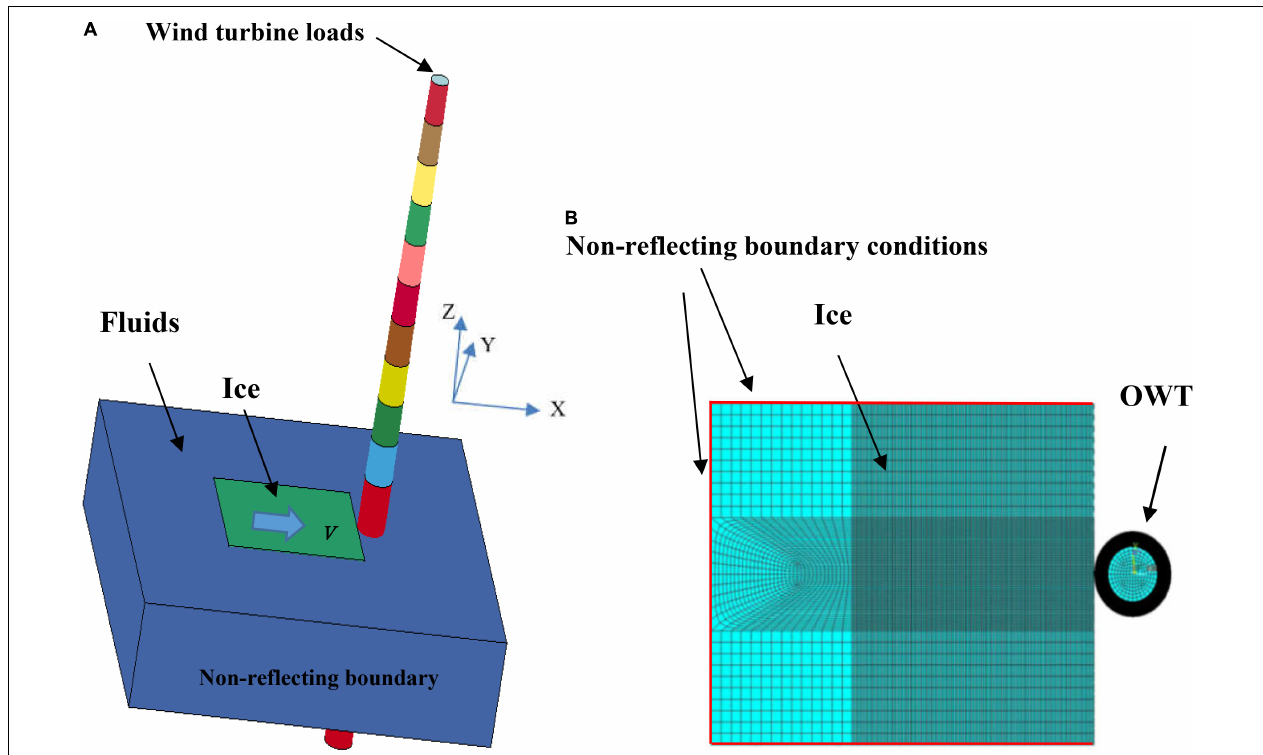
FIGURE 6 | Sea ice and the OWT interaction model with fluid-structure interaction (FSI) coupling. (A) Sea ice-OWT interaction model with FSI coupling; (B) Schematic of the sea ice-OWT interaction.